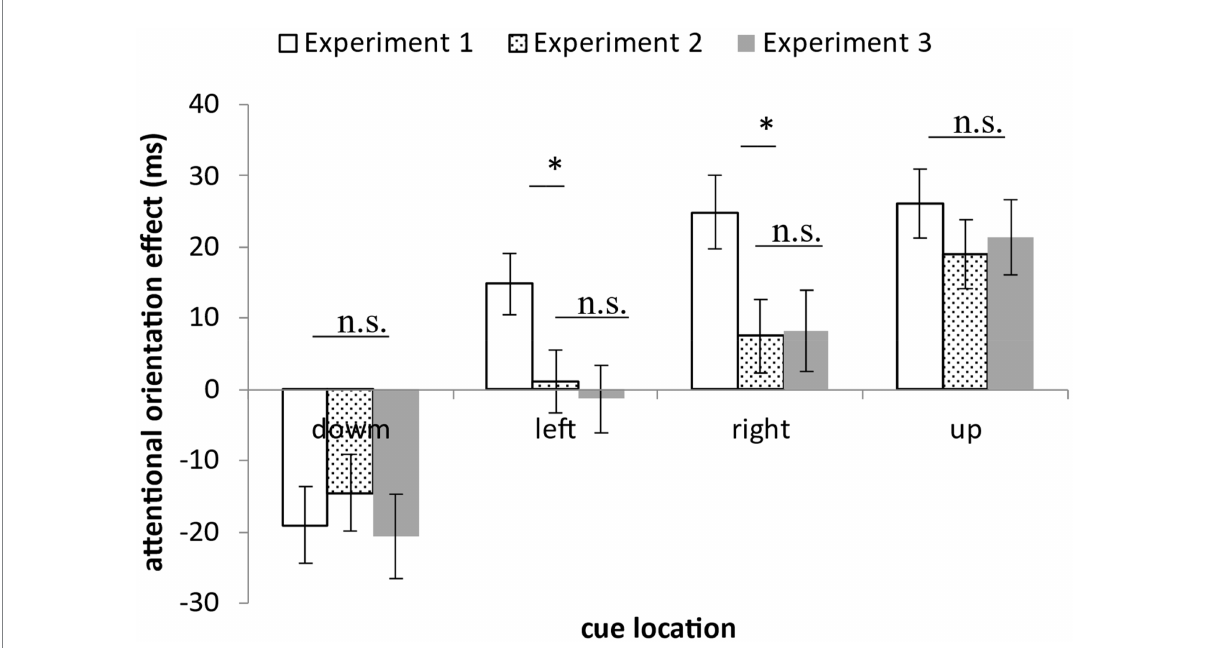
FIGURE 9 Attention orientation effects under different cue positions in Experiments 1–3. When the subliminal cue appeared at the lower and upper positions, there was no difference in the attentional orientation effects among the experiments. While when the subliminal cue appeared at the left and right positions, there was a significant difference in attentional orientation effects among the experiments. Specifically, the attentional orientation effect in Experiment 1 was significantly different from that in Experiment 2 and Experiment 3, while there was no significant difference in attentional orientation effect between Experiment 2 and Experiment 3 (* p < 0.05, n.s. not